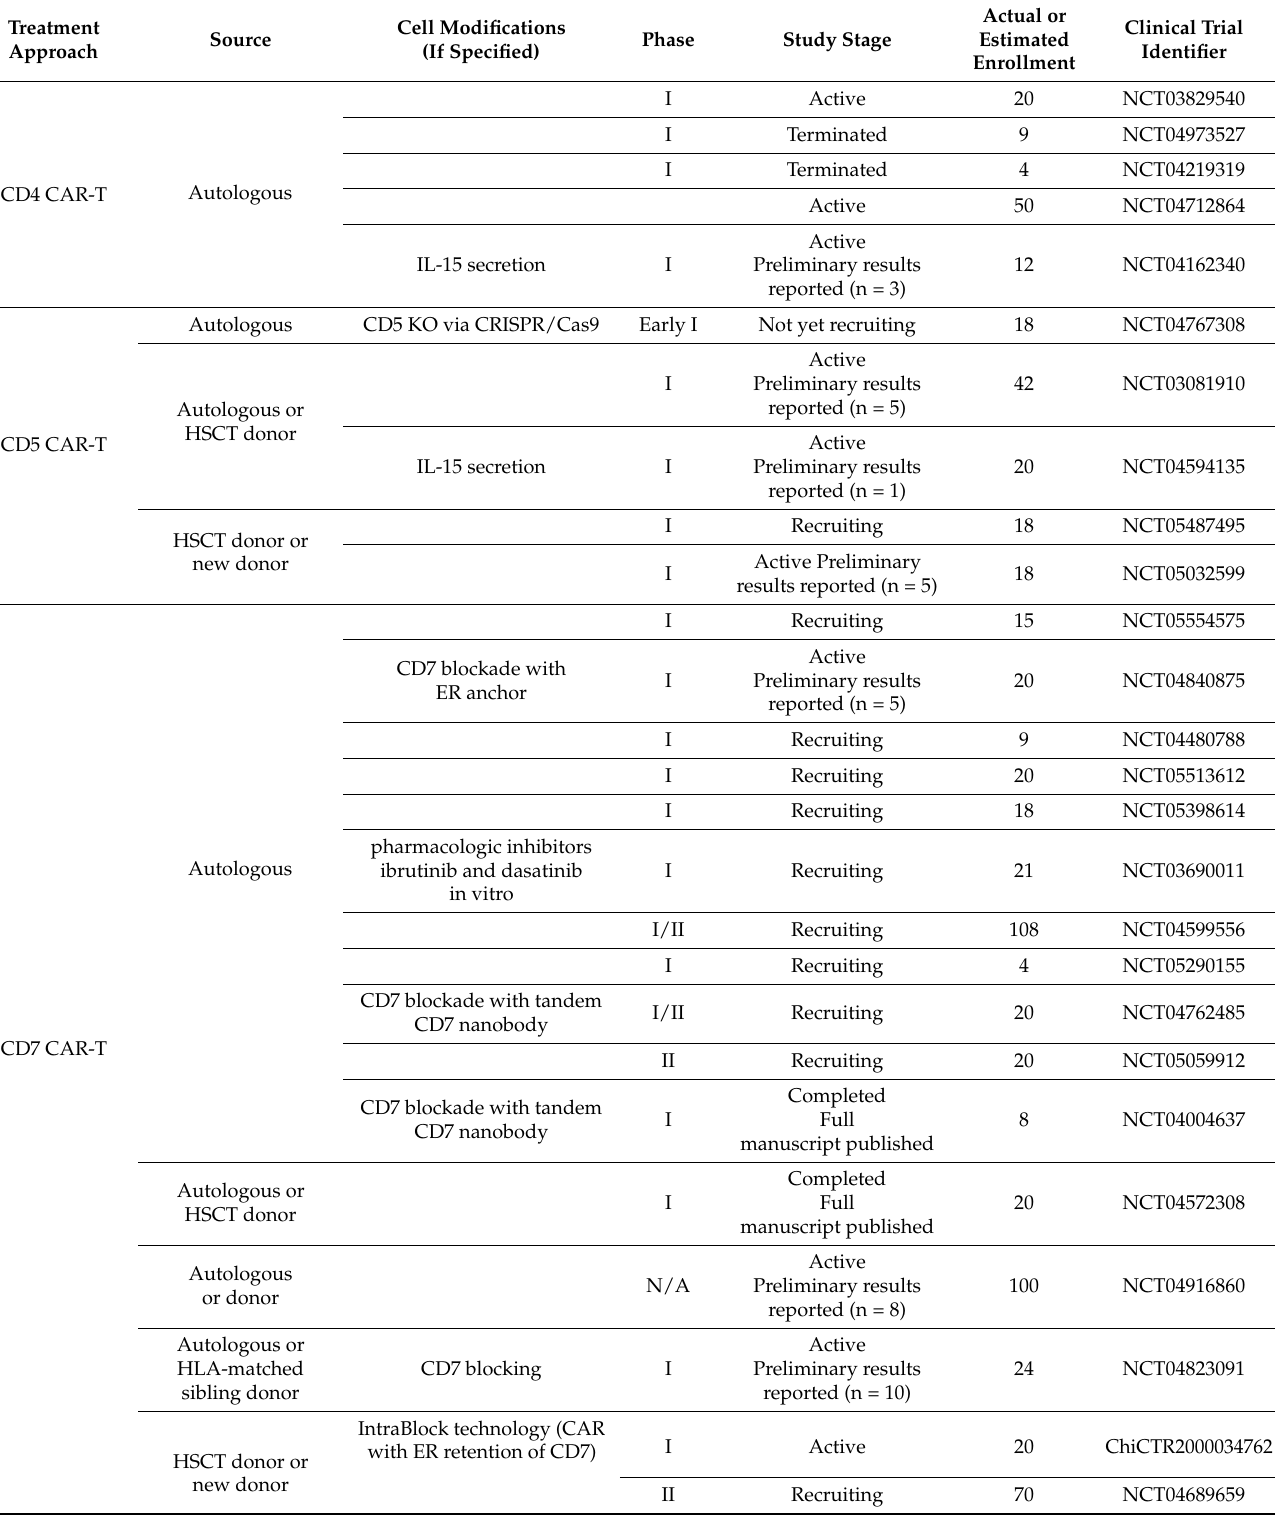
Table 2. List of clinical trials of CAR-T cell therapy for T-cell